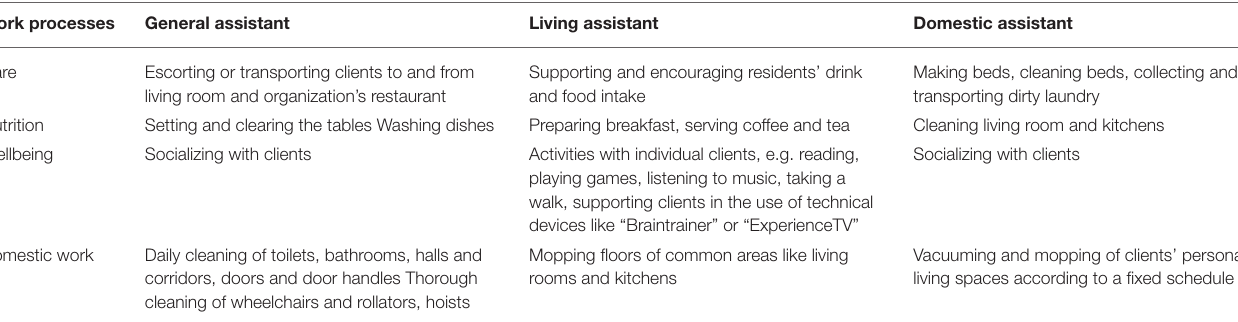
TABLE 1 | Three new assistant functions, examples of tasks. Work